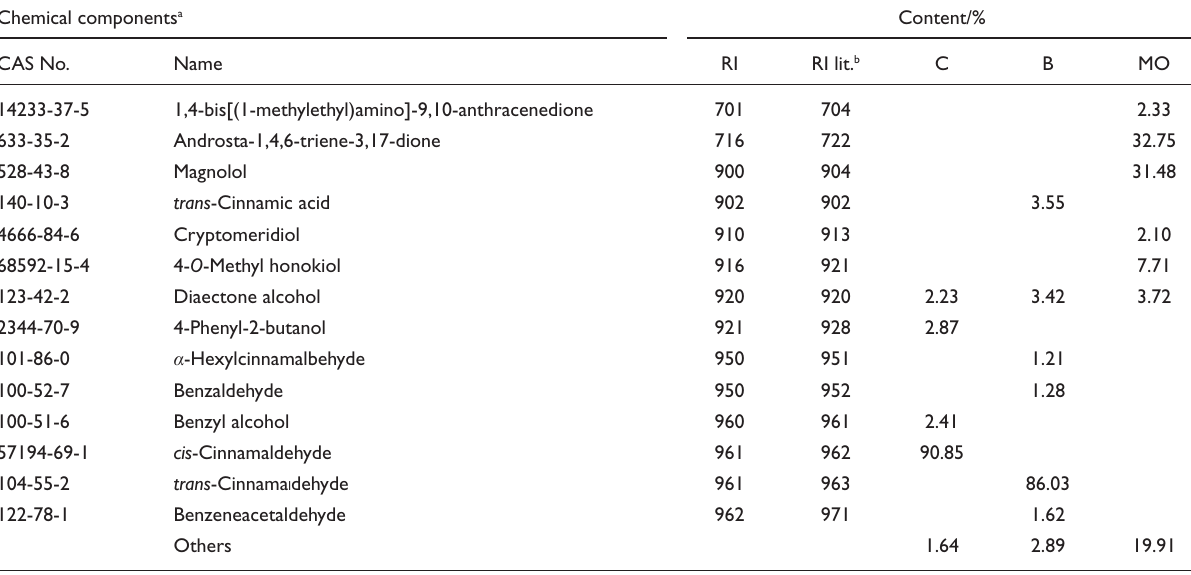
Table 3. Chemical components of cinnamon (C), bay (B), and magnolia officinalis (MO) Chemical components a CAS No.